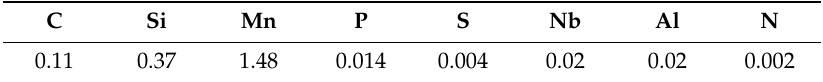
Table 2. Chemical composition (in wt %) of the DH36 steel.